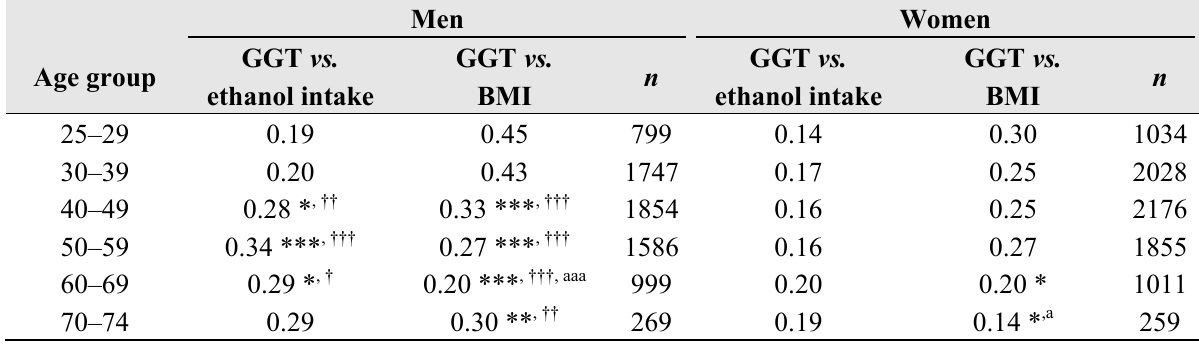
Table 2. Partial correlations between GGT and ethanol intake or GGT and BMI in different age groups of men and